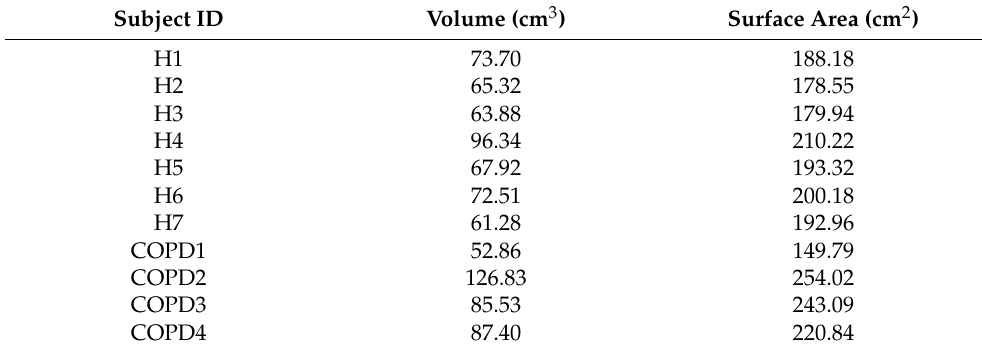
Table A1 lists the volume and surface area of each upper airway geometry shown in Figure A1. Table A1. Dimension of the oral airways.